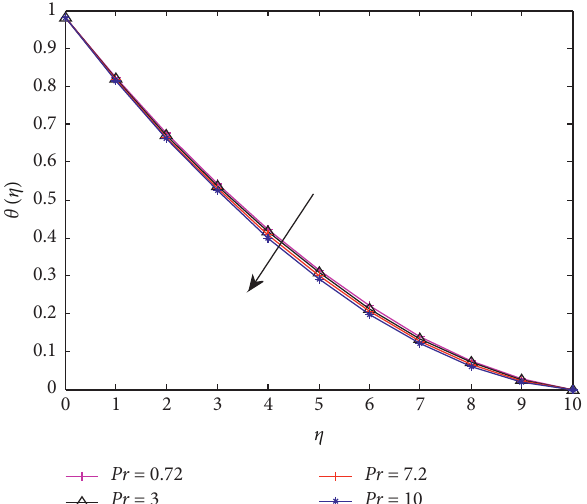
Figure 7: Temperature distribution for numerous values of Pr when Ω � M � λ � R � s � 1, c � 0 . 2 , β � 0 . 2, and Ec � 0 . 1.